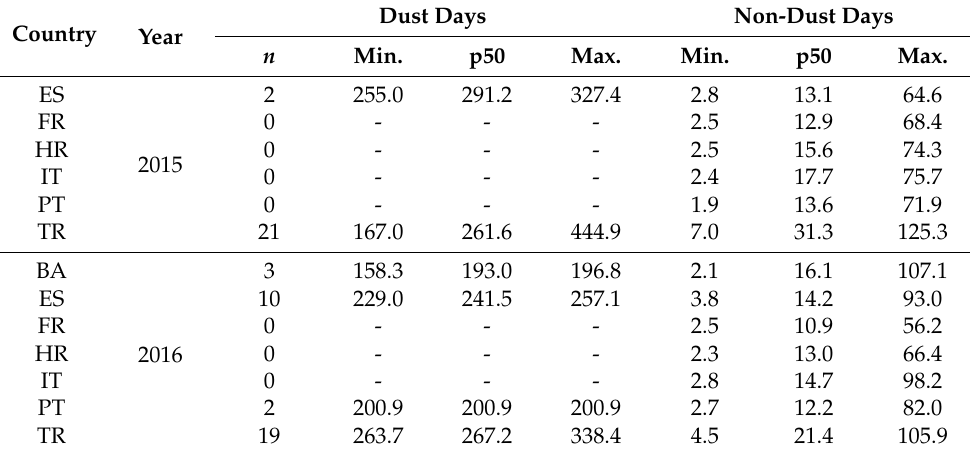
Table 2. Average concentration by country for PM 10 time series during desert and non-desert days in background monitoring sites (in µ g · m − 3 ). n , number of days with exceedance of 150 µ g · m −